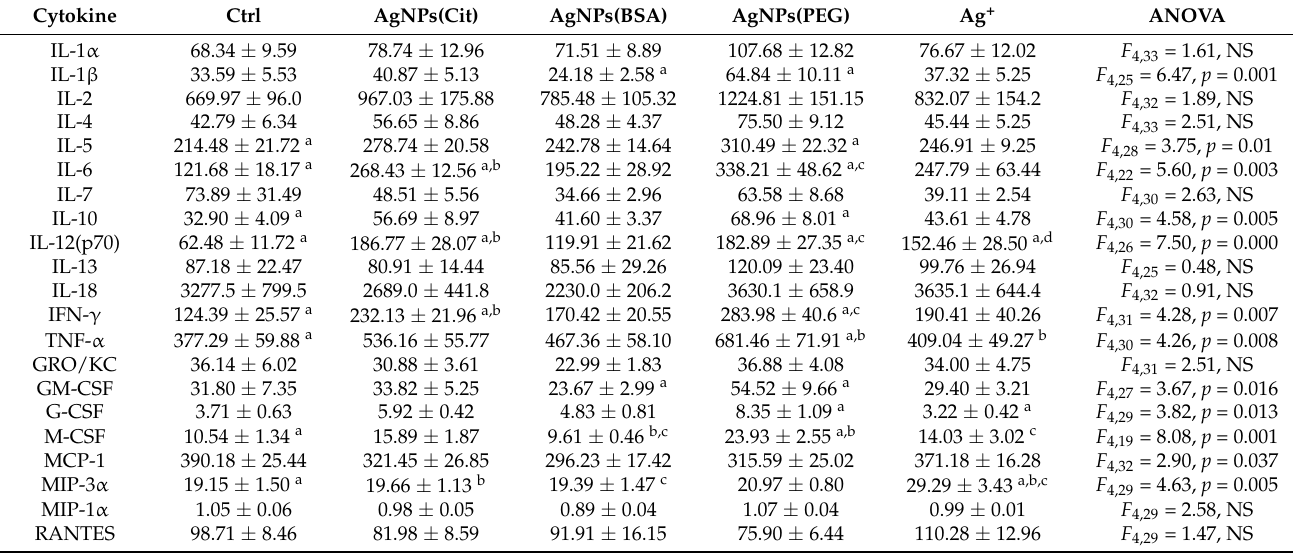
Table 2. Blood plasma cytokine concentration (mean ±